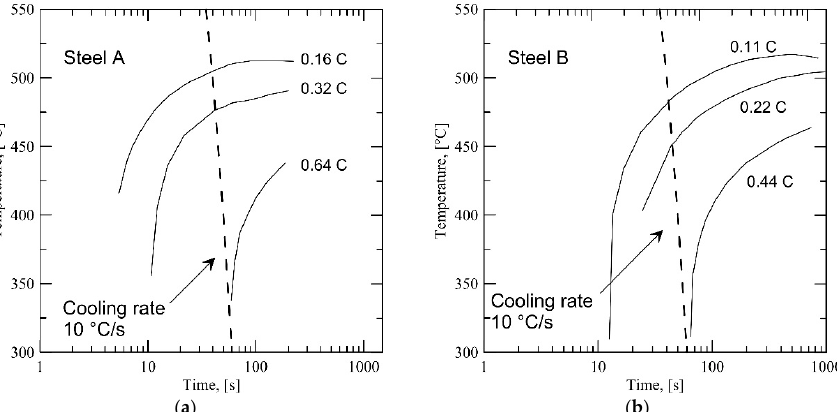
Figure 1. Partial CCT (continuous cooling transformation) curves showing the bainite start lines, calculated for ( a ) Steel A and ( b ) Steel B (see Table 1 for compositions), assuming full partitioning of carbon from ferrite to austenite during intercritical annealing. The carbon concentration for each annealing condition is indicated in wt % next to the corresponding bainite start line.